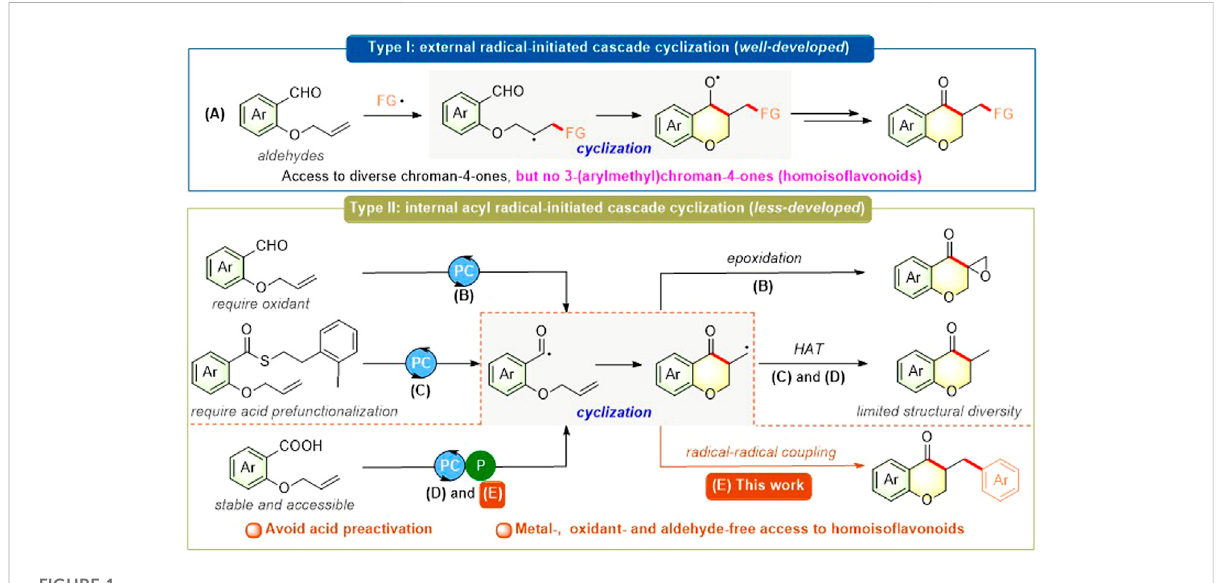
FIGURE 1 Photocatalytic radical-initiated cascade cyclization toward functionalized